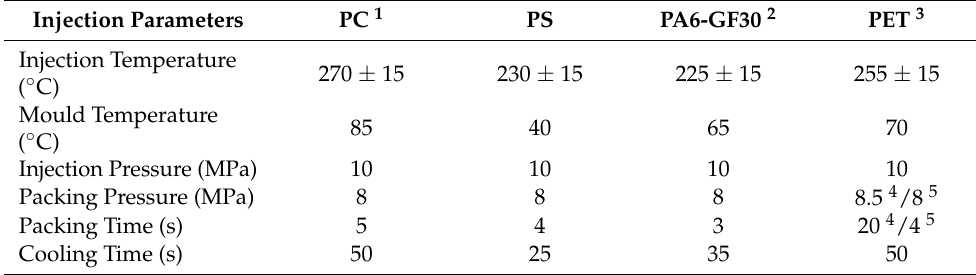
Table 7. Injection moulding processing